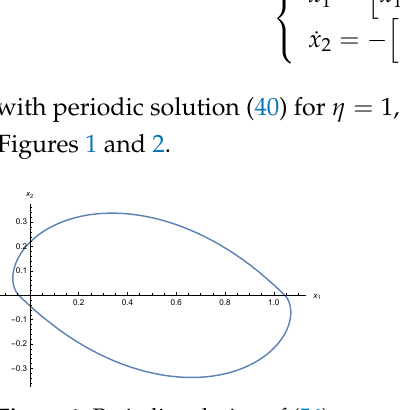
Figure 1. Periodic solution of